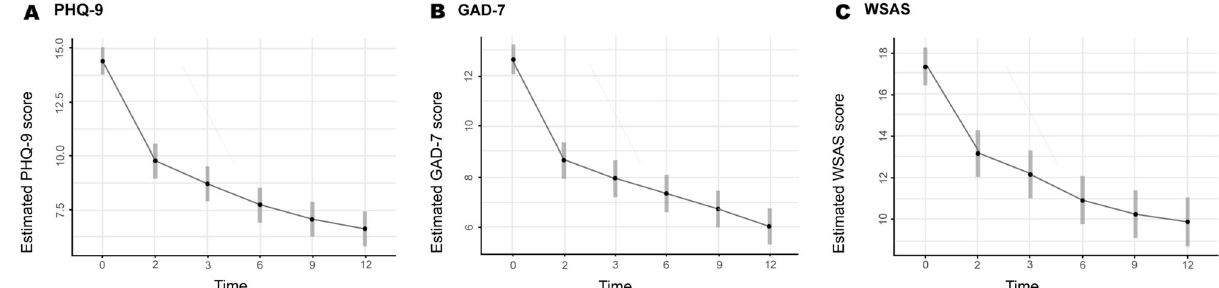
Fig. 3 Intervention-arm estimated marginal means and con fi dence intervals (CI) across all time-points (in months). a Marginal linear model showing estimated mean PHQ-9 score reductions across all timepoints. Bonferroni adjusted estimated mean difference between 8-weeks and (i.e. 2 months) and 12-months 3.12; SE = 0.44; 95% CI 1.82, 4.39; p < 0.0001). b Marginal linear model showing estimated mean PHQ-9 score reductions across all timepoints. Bonferroni adjusted estimated mean difference between 8-weeks and (i.e. 2 months) and 12-months 2.60; SE = 0.40; 95% CI 1.43, 3.76; p < 0.0001). c Marginal linear model showing estimated mean PHQ-9 score reductions across all timepoints. Bonferroni adjusted estimated mean difference between 8-weeks and (i.e. 2 months) and 12-months 3.24; SE = 0.62; 95% CI 1.40, 5.07; p <